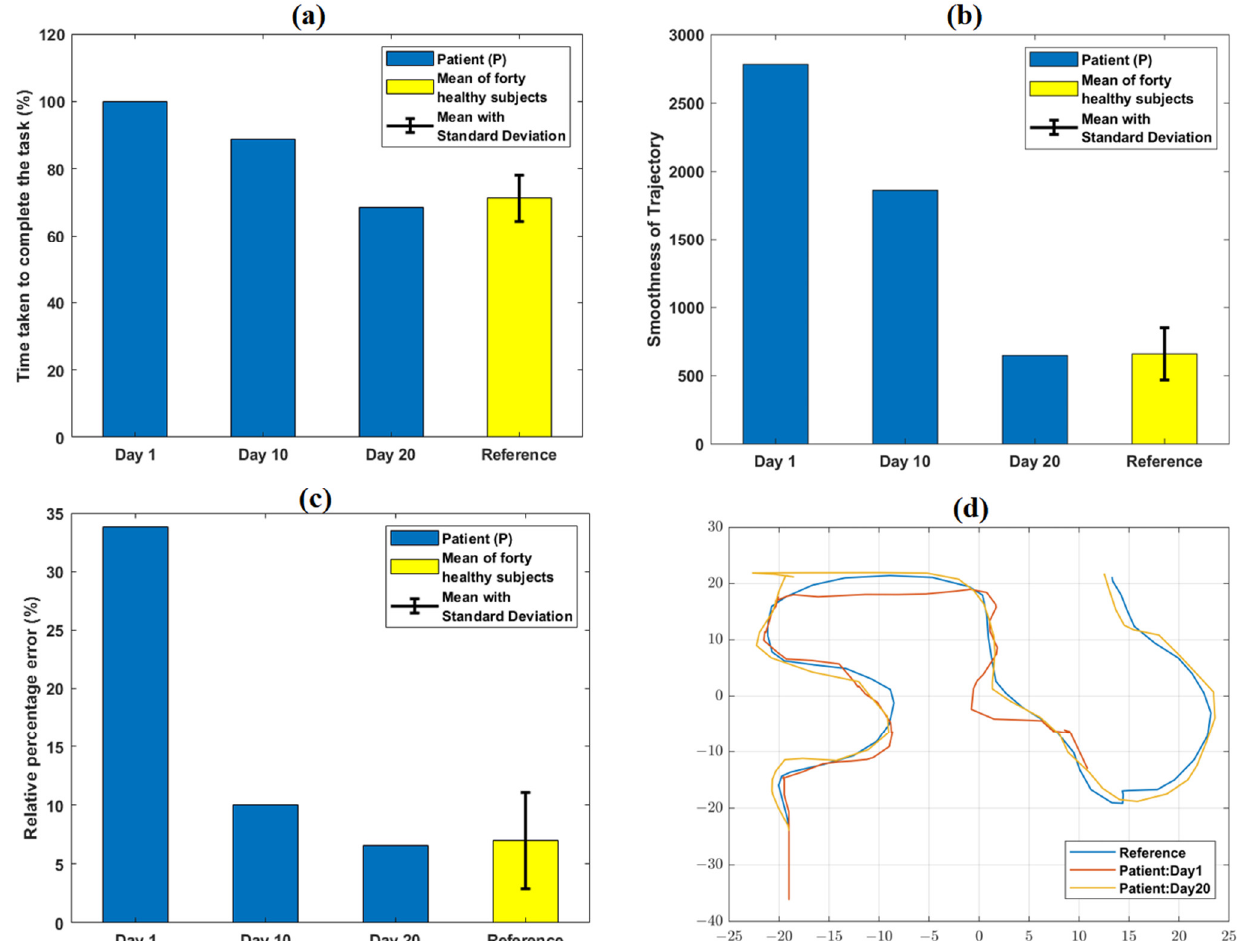
Figure 5. Variation in quantitative task-specific performance metrics: ( a ) TCT, ( b ) smoothness of trajectory, and ( c ) relative % error obtained from the patient (P) at day 1, 10, and 20 of VR therapy. A relative decrease in TCT, smoothness of trajectory, and relative % error values was observed from day 1 to day 20. The reference values shown were obtained from the average performance metrics of 40 healthy subjects in our earlier work. ( d ) shows qualitative trajectory plots for day 1 and 20 obtained from P. At day 1, the trajectory of P was incomplete; it became identical with that of a representative healthy subject (obtained from our previous work) at day 20.